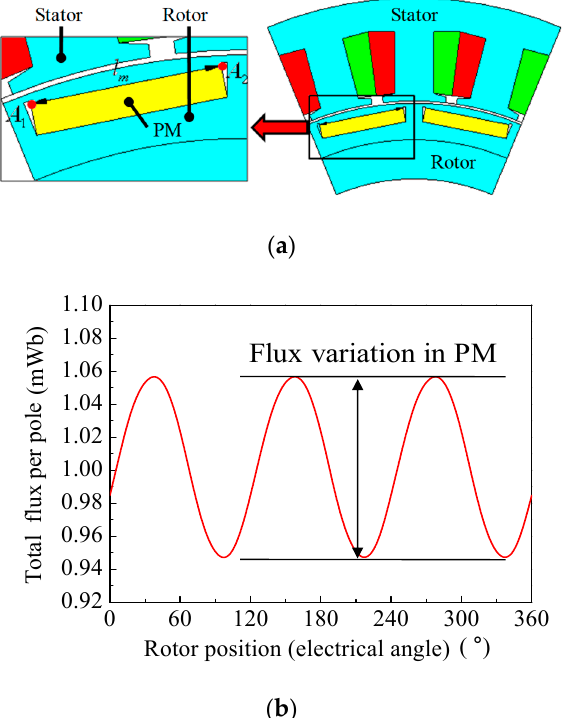
Figure 2. Flux variation in PM with respect to rotor position. ( a ) Magnetic vector potential and length of PM; ( b ) flux variation in PM.